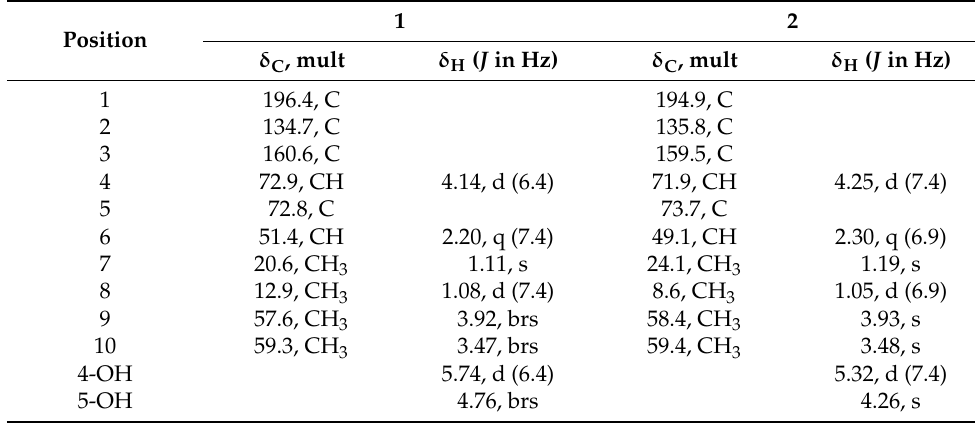
Table 1. NMR data (700 MHz, DMSO-d 6 , δ in ppm) for compounds 1 and 2 .